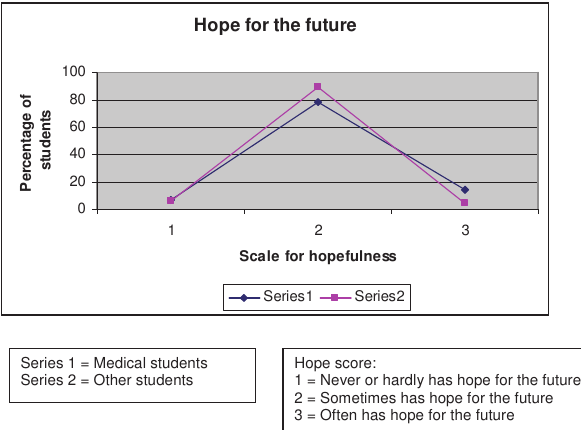
Fig. 3. Subjective experience of hope.